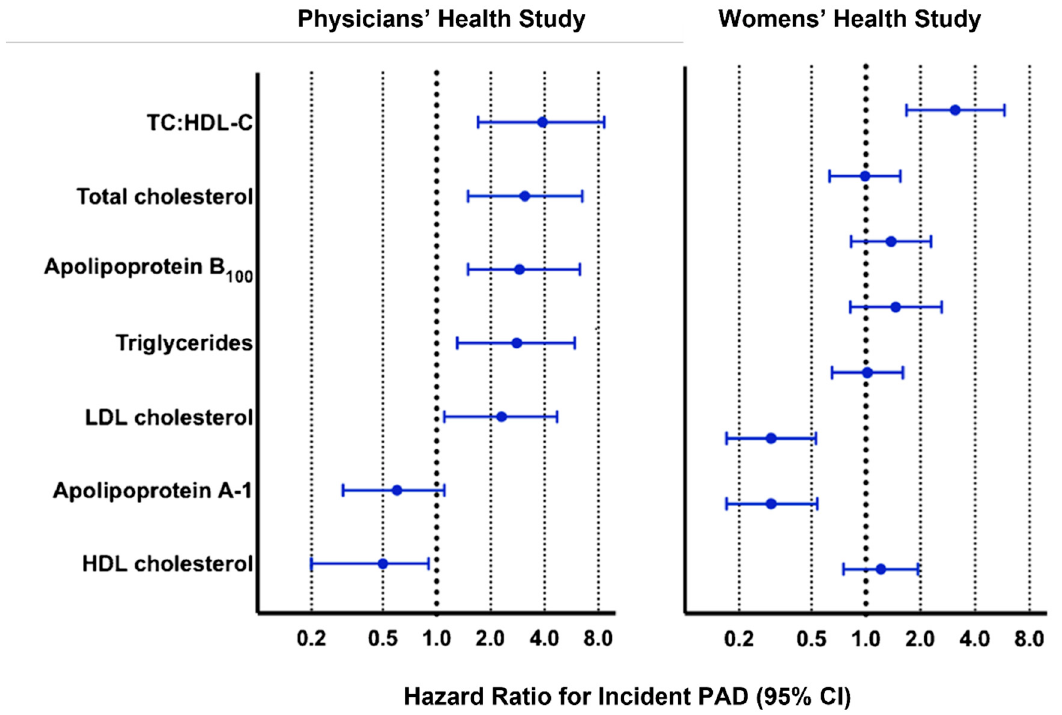
Figure 1. Left panel: Adjusted hazard ratio of lipids and apolipoproteins and PAD in the Physicians’ Health Study. Note relative risk and 95% confidence intervals for the top and bottom quartile of